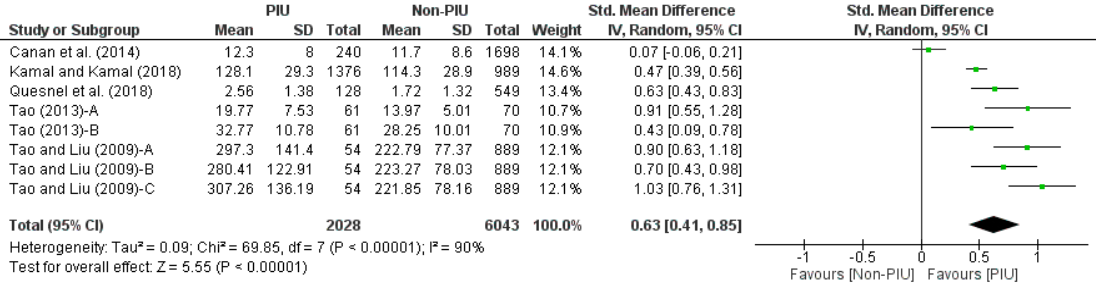
Figure 3. Forest plot of meta-analysis with continuous data.